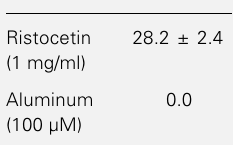
Table 4 - Effects of alumi- num (100 (cid:181)M) and ristoce- tin (1 mg/ml) on platelet ag- glutination. Data are reported as means – SEM of 5 determinations. Cells were stimulated for 5 min at 37 o C with aluminum or ristocetin. For further details see Material and